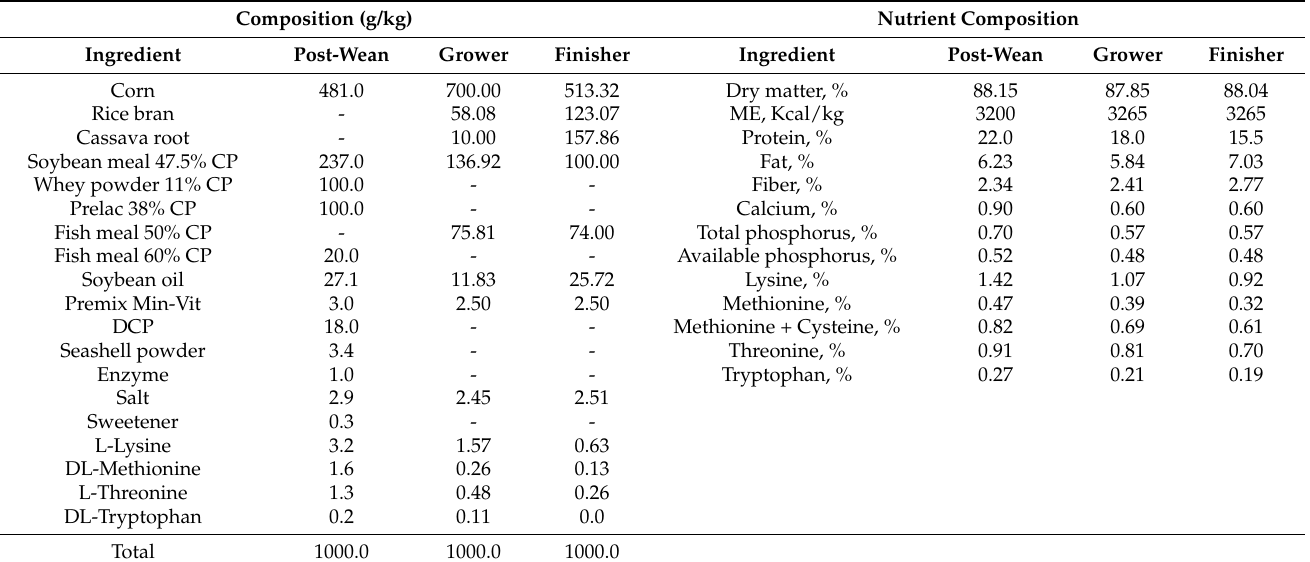
Table 1. Composition of basal diets for Starter, Grower, and Finisher phases 1